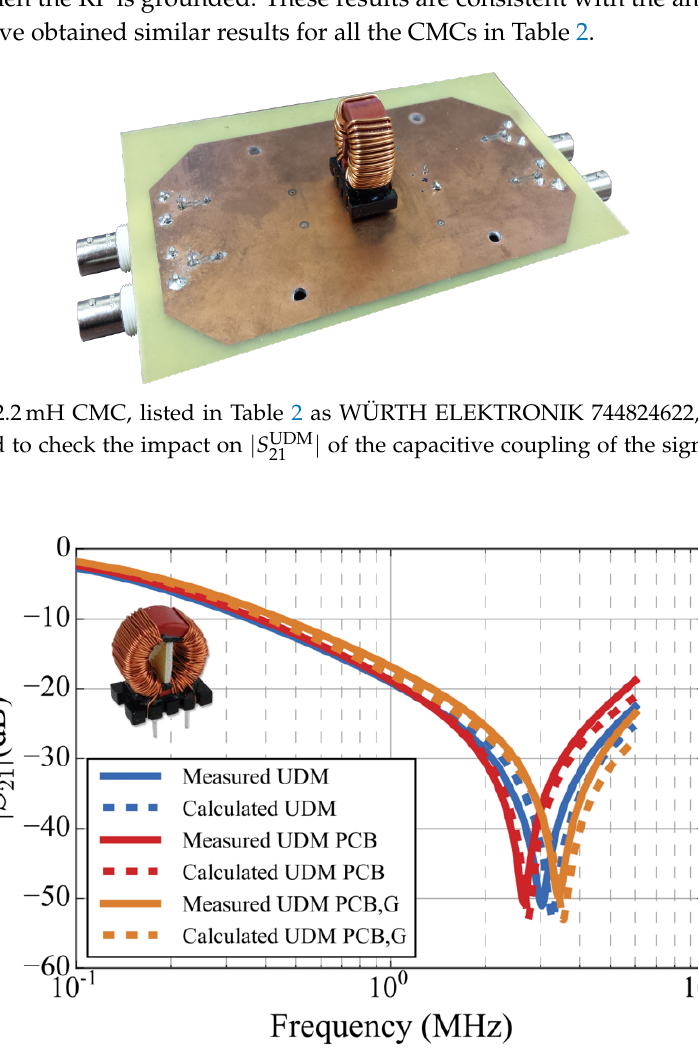
| curves for the CMC listed as WÜRTH ELEKTRONIK Figure 11. Measured and calculated | S UDM 21 744824220 (20 mH) in Table 2. We compare curves for three cases: standalone CMC, CMC mounted on a PCB with a floating return plane and CMC mounted on a PCB whose return plane is grounded (G